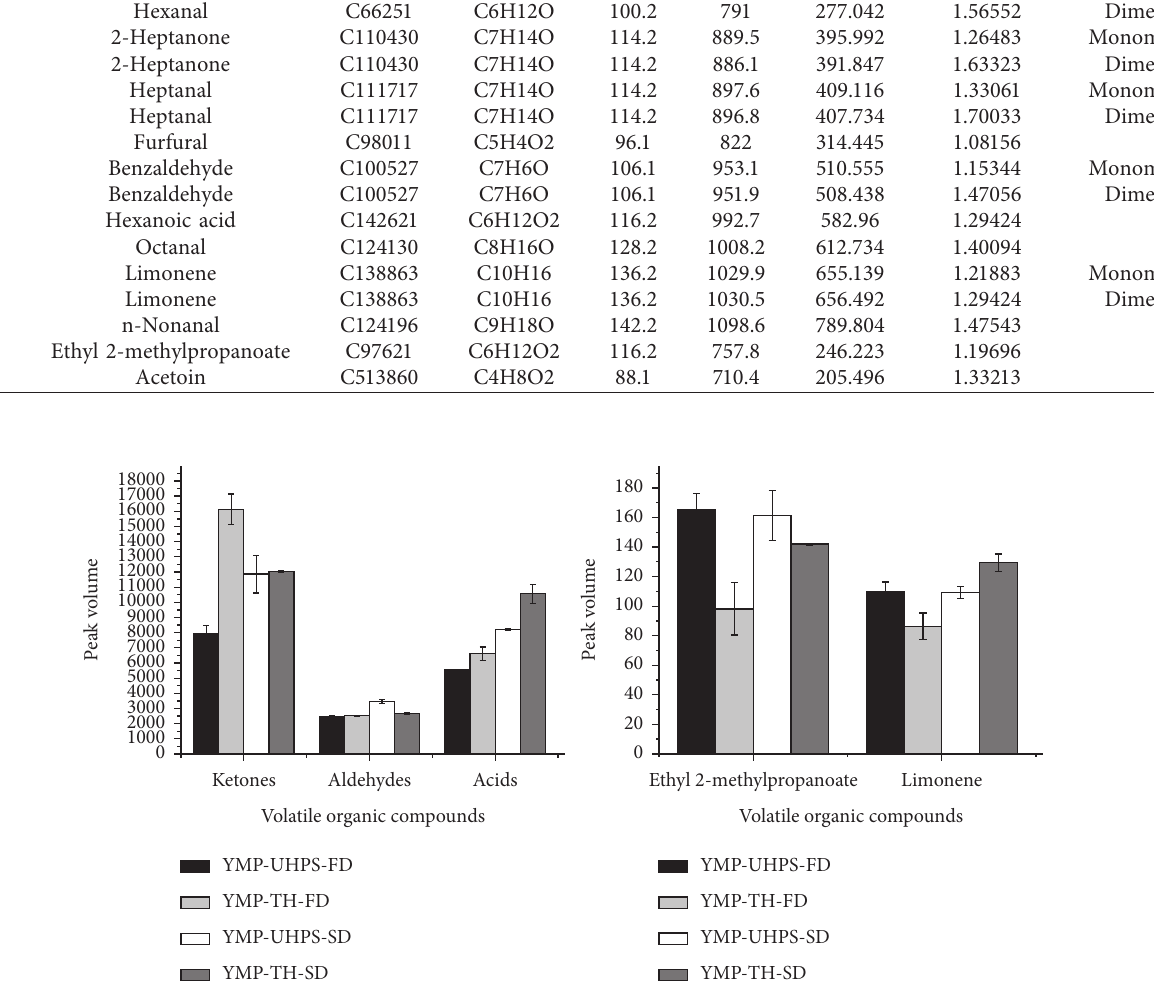
Figure 2: GC-IMS peak volume of different YMP